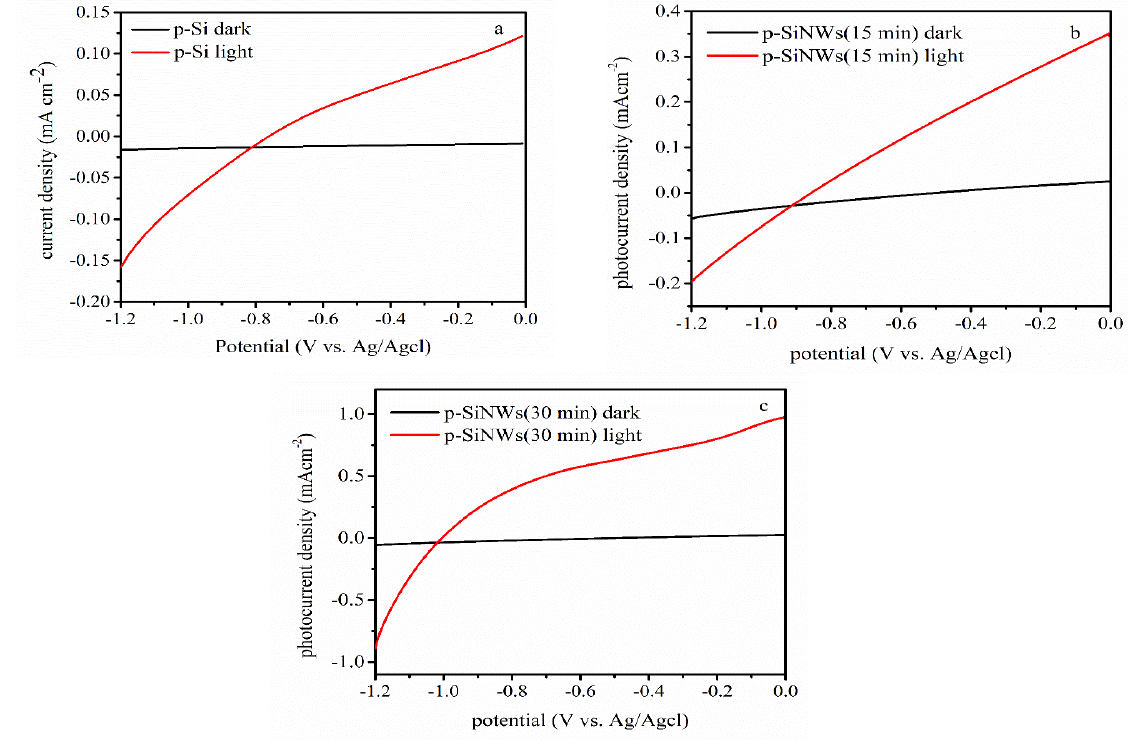
Figure 3: Linear sweep voltammetry (J-V) of Si (100) wafer photocathode and SiNWs photocathode prepared by etching time of 15 min and 30 under dark and light conditions.